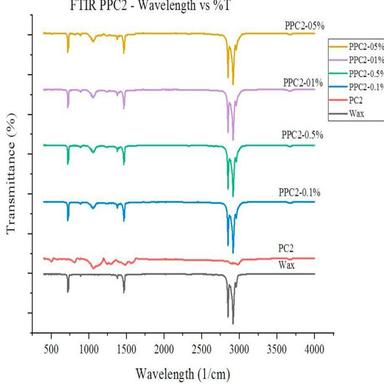
FTIR spectrum for PPC2 - Wavelength Vs %T.